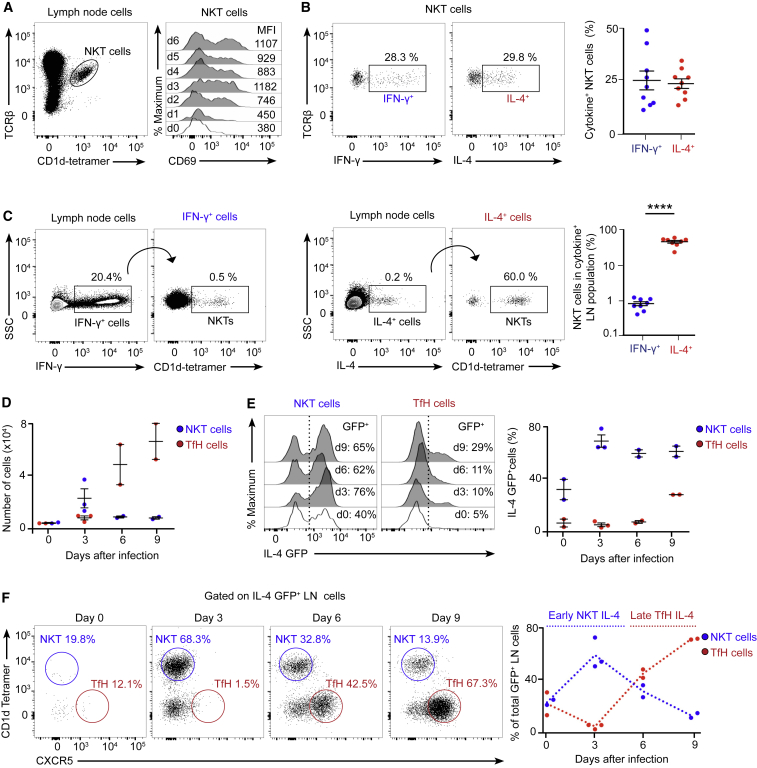
NKT Cells Generate a Pre-TfH Cell Wave of IL-4(A) Flow cytometry analysis of CD69 levels in the TCRβ+ CD1d tetramer+ population after 0–6 days of influenza infection. MFI, mean fluorescence intensity.(B) Representative plots showing the percentage of NKT cells producing IFN-γ (blue) and IL-4 (red) after 3 days of influenza infection.(C) Flow cytometry analysis of IFN-γ (blue) and IL-4 (red) production on day 3 of influenza infection. Gates were drawn on IFN-γ+ and IL-4+ lymph node cells to analyze the percentage of NKT cells inside each cytokine+ population.(D–F) Flow cytometry analysis of NKT (blue) and TfH (red) cells from IL-4 GFP mice infected with influenza virus.(D) Numbers of NKT and TfH cells at different stages of influenza infection.(E) GFP expression in NKT and TfH cells at different times of infection.(F) Percentage of CD1d-tetramer+ NKT cells and CXCR5+ TfH cells inside the IL-4 GFP+ lymph node cell population at different stages of influenza infection.In all charts, each dot represents one mouse. In graphs showing statistical analysis, data are representative of three independent experiments. Horizontal bars, mean; error bars, SEM. Student’s t test, ∗∗∗∗p < 0.0001.